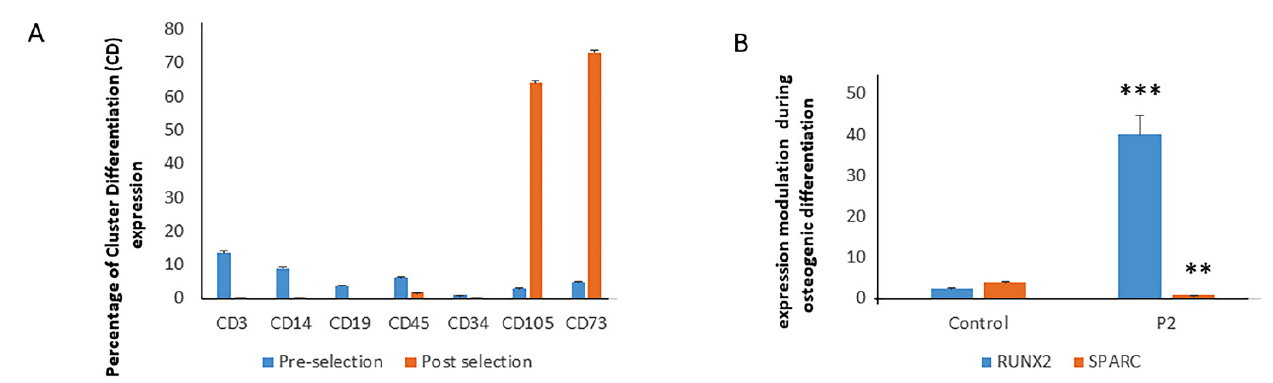
Figure 4. Mesenchymal Markers CD105 and CD73 were expressed to a percentage greater than 60% while hematopoietic markers were expressed at low levels ( A ). In cMSCs, following osteogenic differentiation, RUNX2 gene expression increased while SPARC decreased in Pt2 cMSCs compared to control ( B ). Two (for the evaluation of percentage of Cluster Differentiation expression) or three (for the evaluation of RUNX2 and SPARC expression) independent analyses in samples of each participant were performed in triplicate, and data are shown as mean ± standard deviation (SD). ** p < 0.005; *** p < 0.0001.